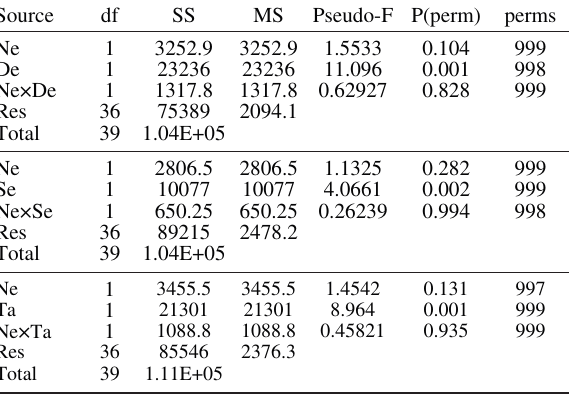
Table S1. – Two-way PERMANOVA table with factors net type (Ne) and depth (De), net type (Ne) and season (Se), and net type and target catch (Ta) for abundance of combined catch (includes commercial, commercial discard and